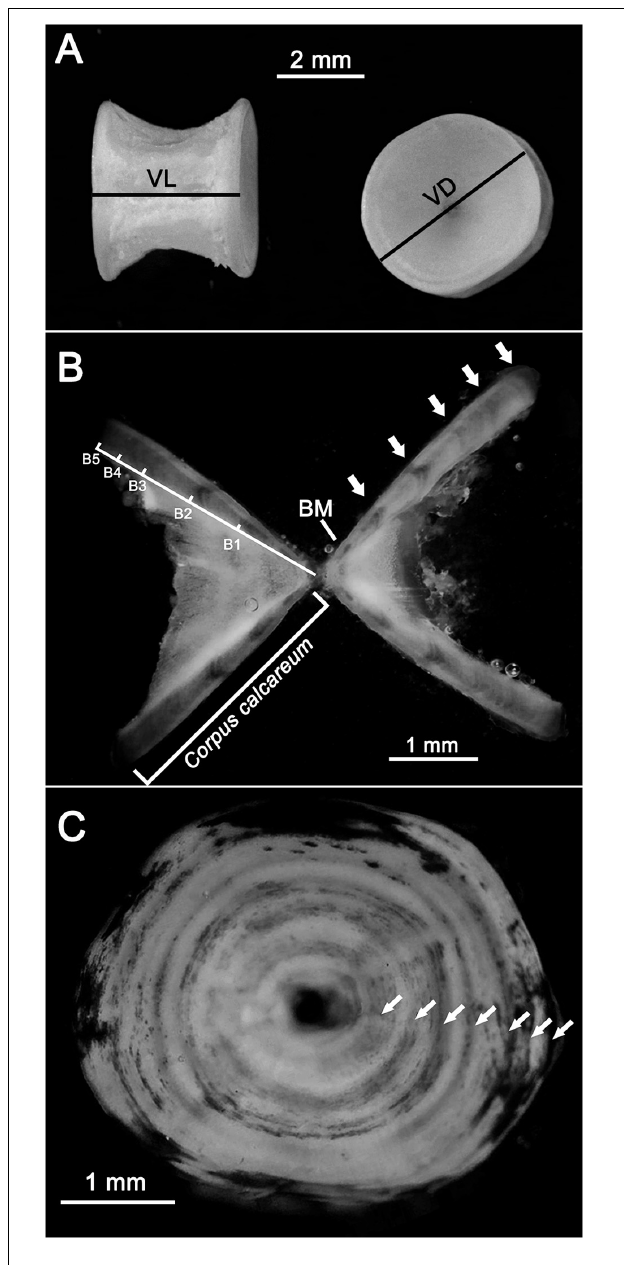
FIGURE 2 | Vertebral centra after cleaning. The vertebral length (VL) and vertebral diameter (VD) are indicated (A) . Thin section of a vertebral centrum (B) of a female R. clavata ( TL = 66.4 cm) caught in February. The corpus calcareum and band length (B 1 , B 2 ... B n ) measurements, the birthmark (BM), and the transparent bands (white arrows) are shown. Whole vertebral centrum (C) of a female specimen (caught in March; TL = 73.7 cm) stained by the cobalt nitrate and ammonium sulfide technique. The transparent bands are indicated by white